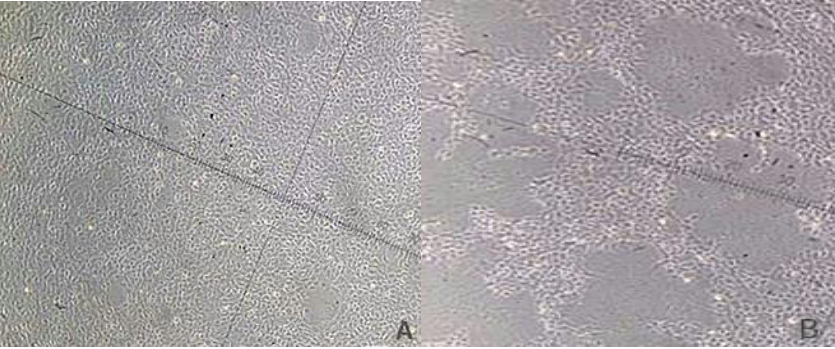
Figure 1. Cytopathy of epithelioma papulosum cyprinid (EPC) cells after virus infection (100×).